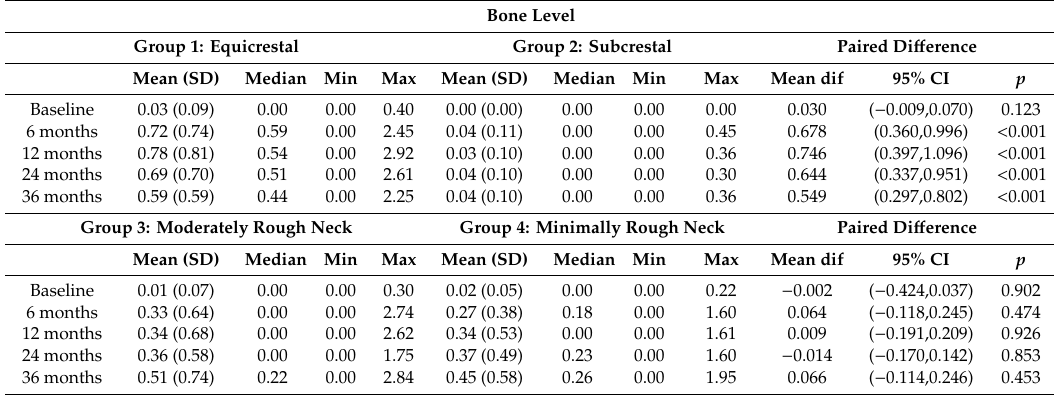
Table 2. Mean bone level for each study group and the bone level di ff erence between respectively equicrestally versus subcrestally placed implants and implants with moderately rough versus minimally rough neck; p < 0.05 indicates a statistically significant di ff erence (paired t -test).